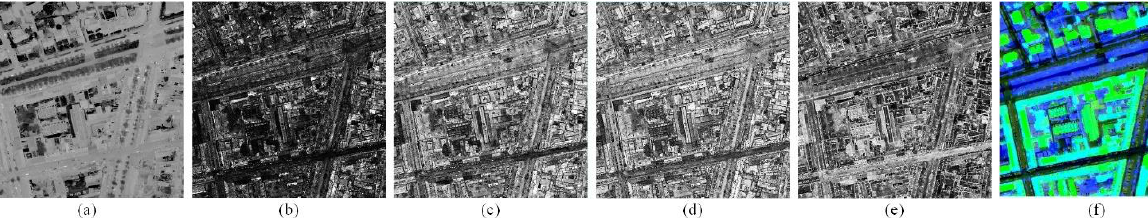
Figure 5. Heterogeneous Feature Map Flowchart.